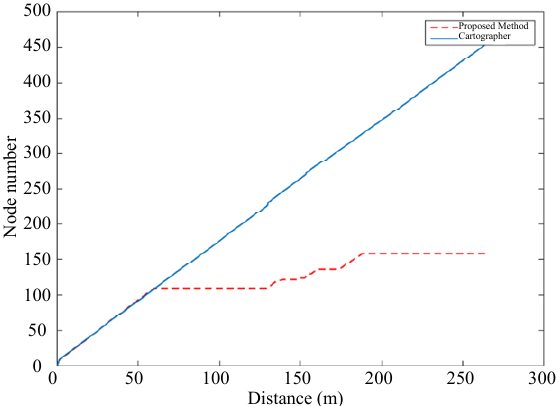
Fig. 13 Pose-graph nodes. The relationship between the number of nodes in the pose graph and the running